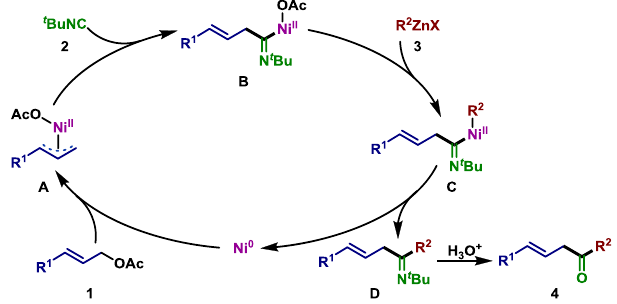
Fig. 7 Tentative mechanism. Possible reaction pathway of the carbonylative coupling